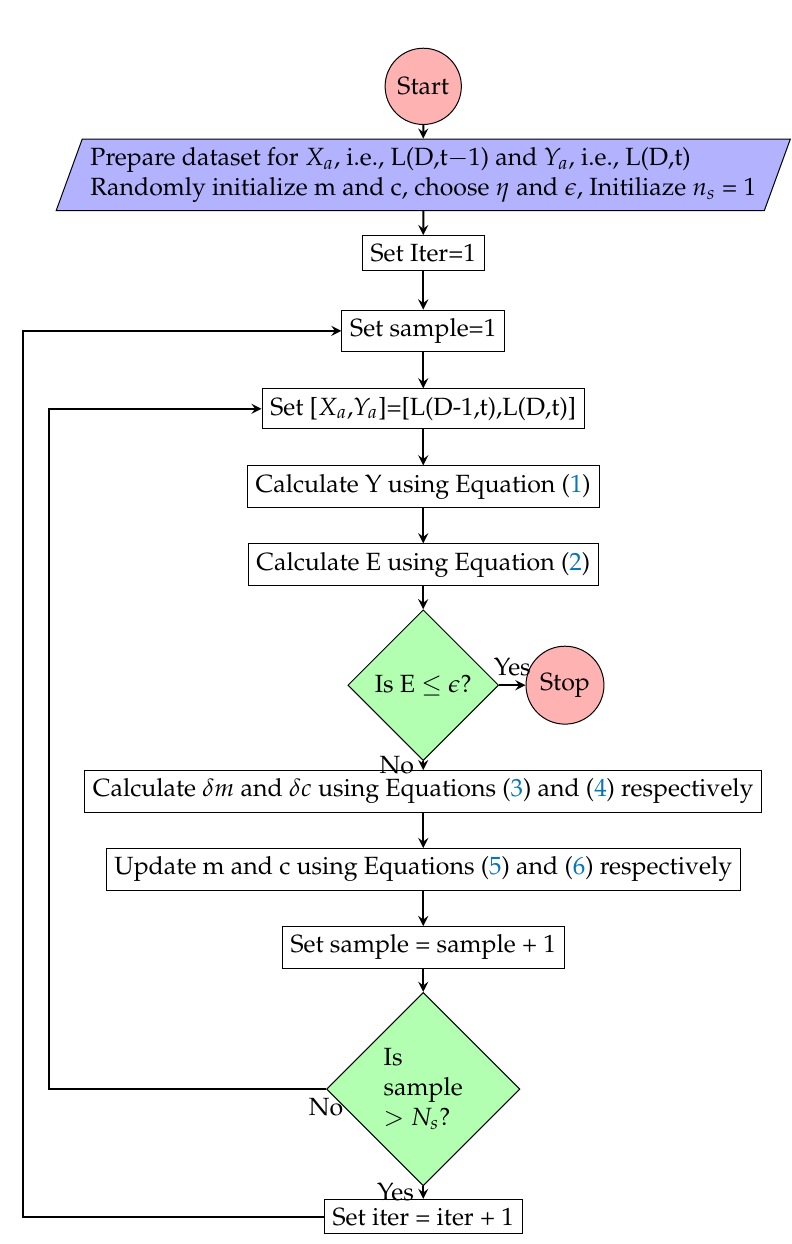
Figure 3. Simple Linear Regression model training